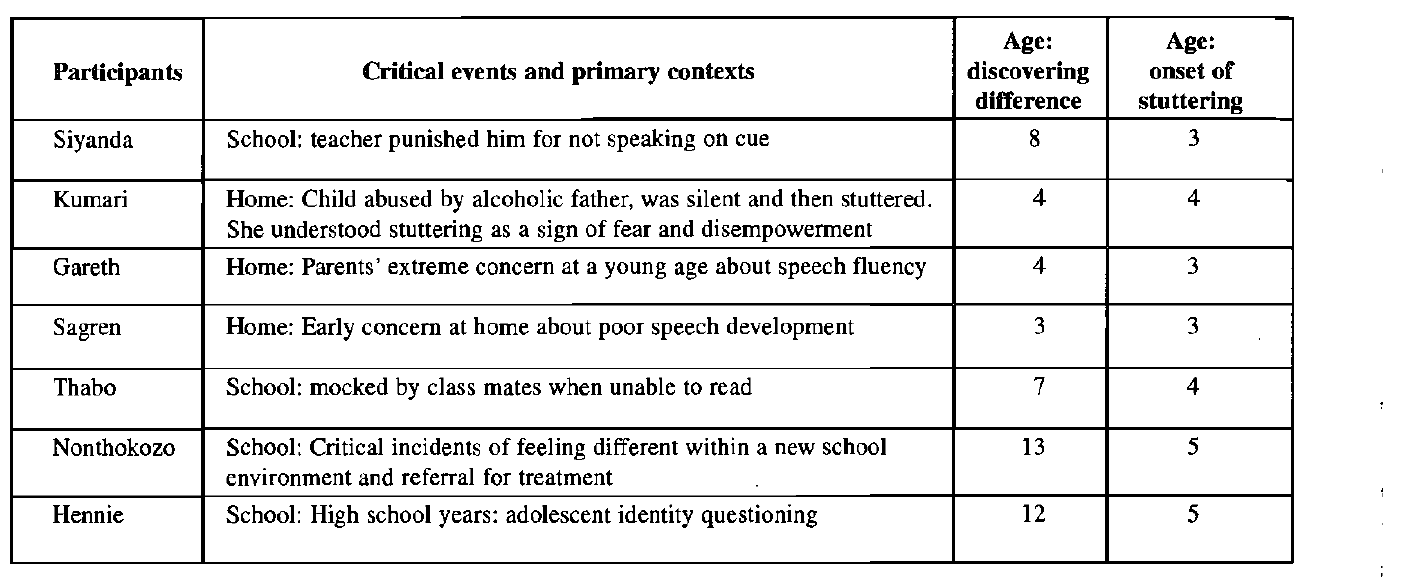
Age: Age: discovering onset of difference